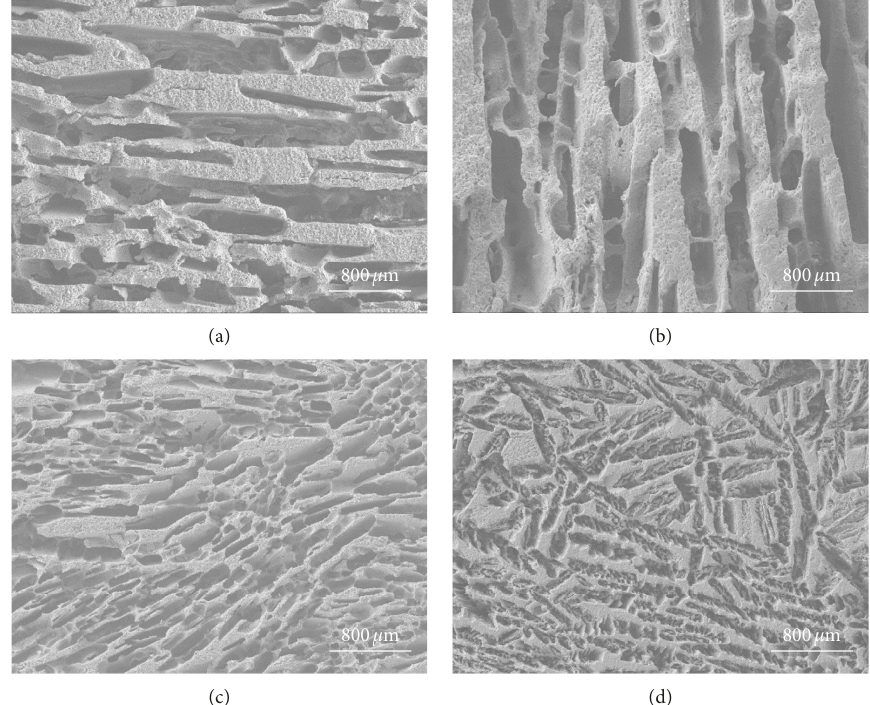
Figure 3: SEM images of porous HA scaffolds prepared at different cooling speeds: (a) 1.3 ° C/min; (b) 2.2 ° C/min; (c) 4.8 ° C/min; (d) 5.5 ° C/min.